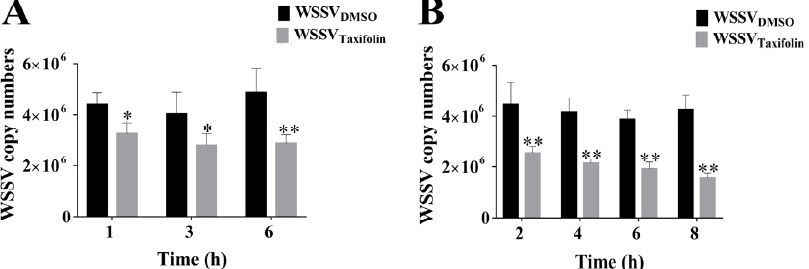
Figure 3. The replication of WSSV was inhibited by preincubation of WSSV virions and shrimp with taxifolin. ( A ) Taxifolin (100 µ M) was preincubated with the WSSV virions for 1, 3 and 6 h, respectively. Inhibition was enhanced within an increased exposure time of taxifolin to the